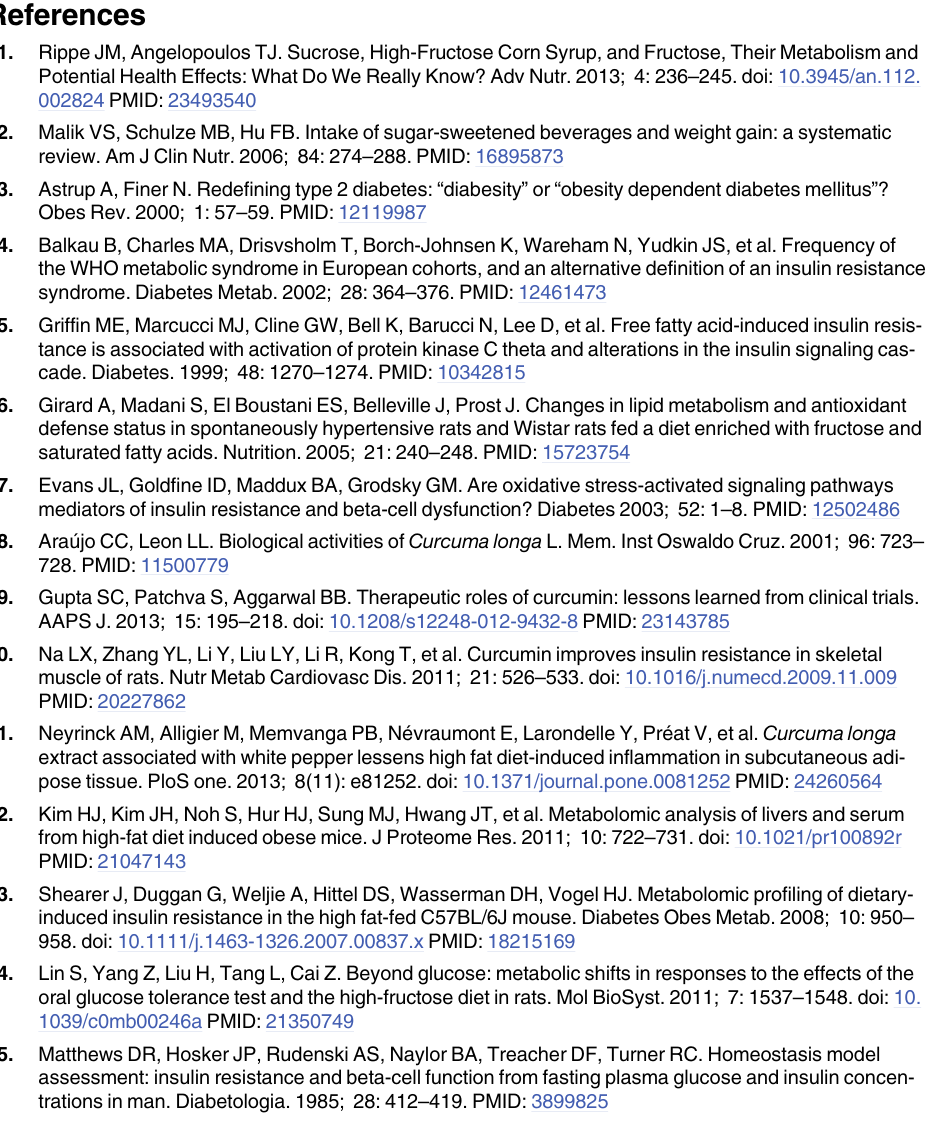
S1 Table. Assignment of 1 H and 13 C NMR signals of metabolites.